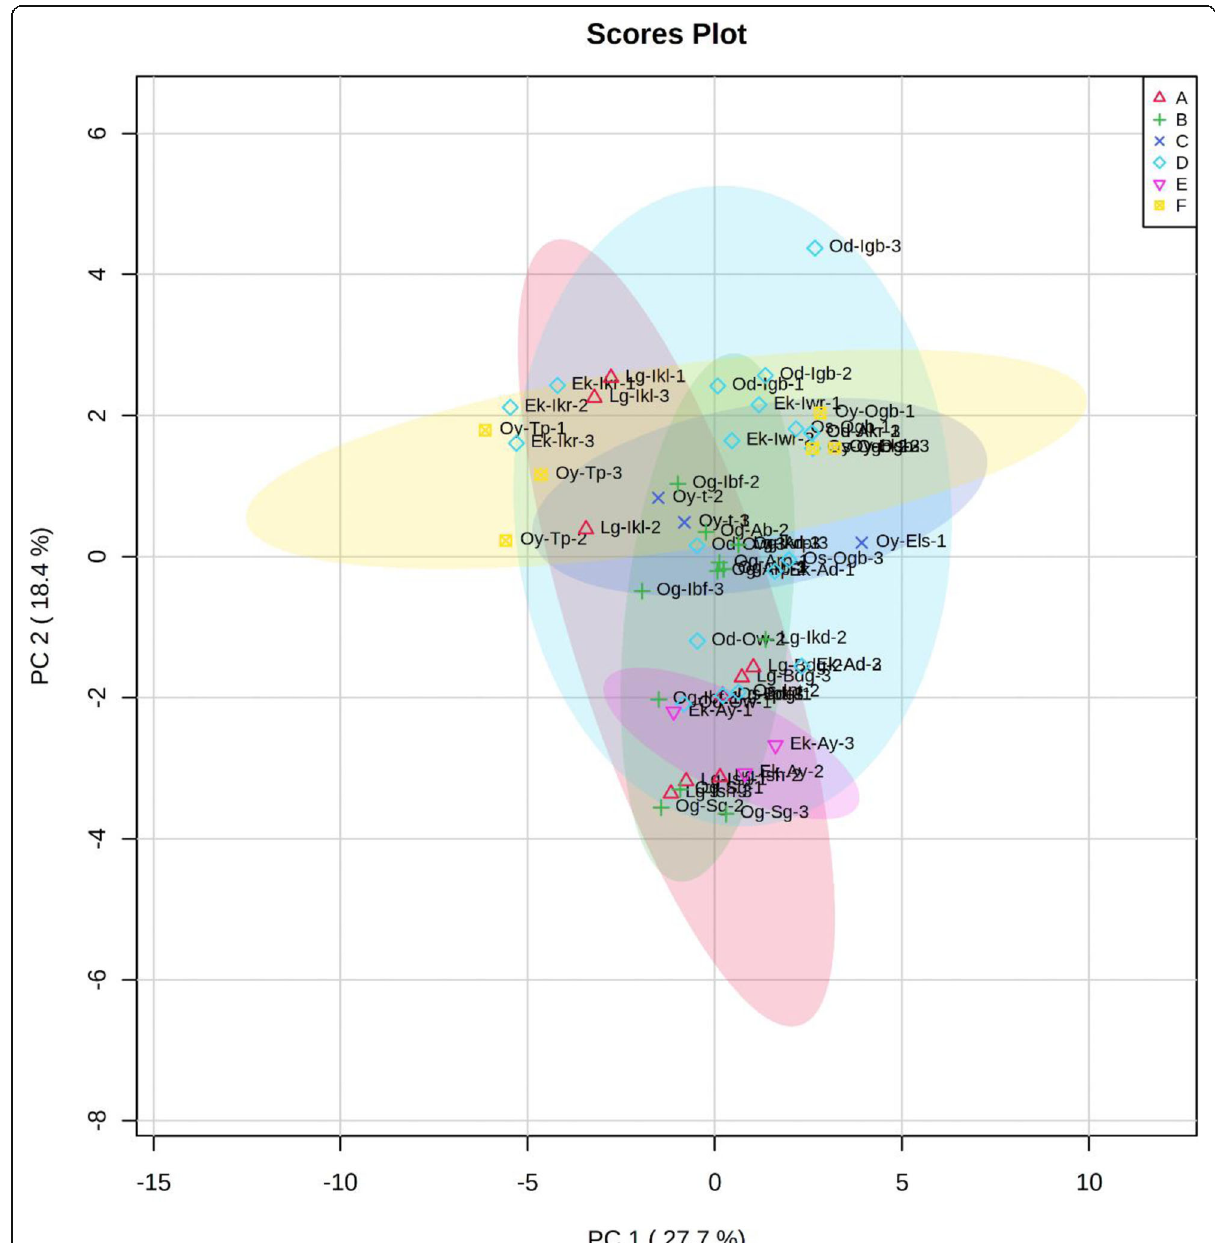
Fig. 12 PCA plot from groups according to the type of soil as indicated by the Global Mapping Unit. A = 1656, B = 1550-1554, C = 1475, D = 1484-1487, E = 1588, F =